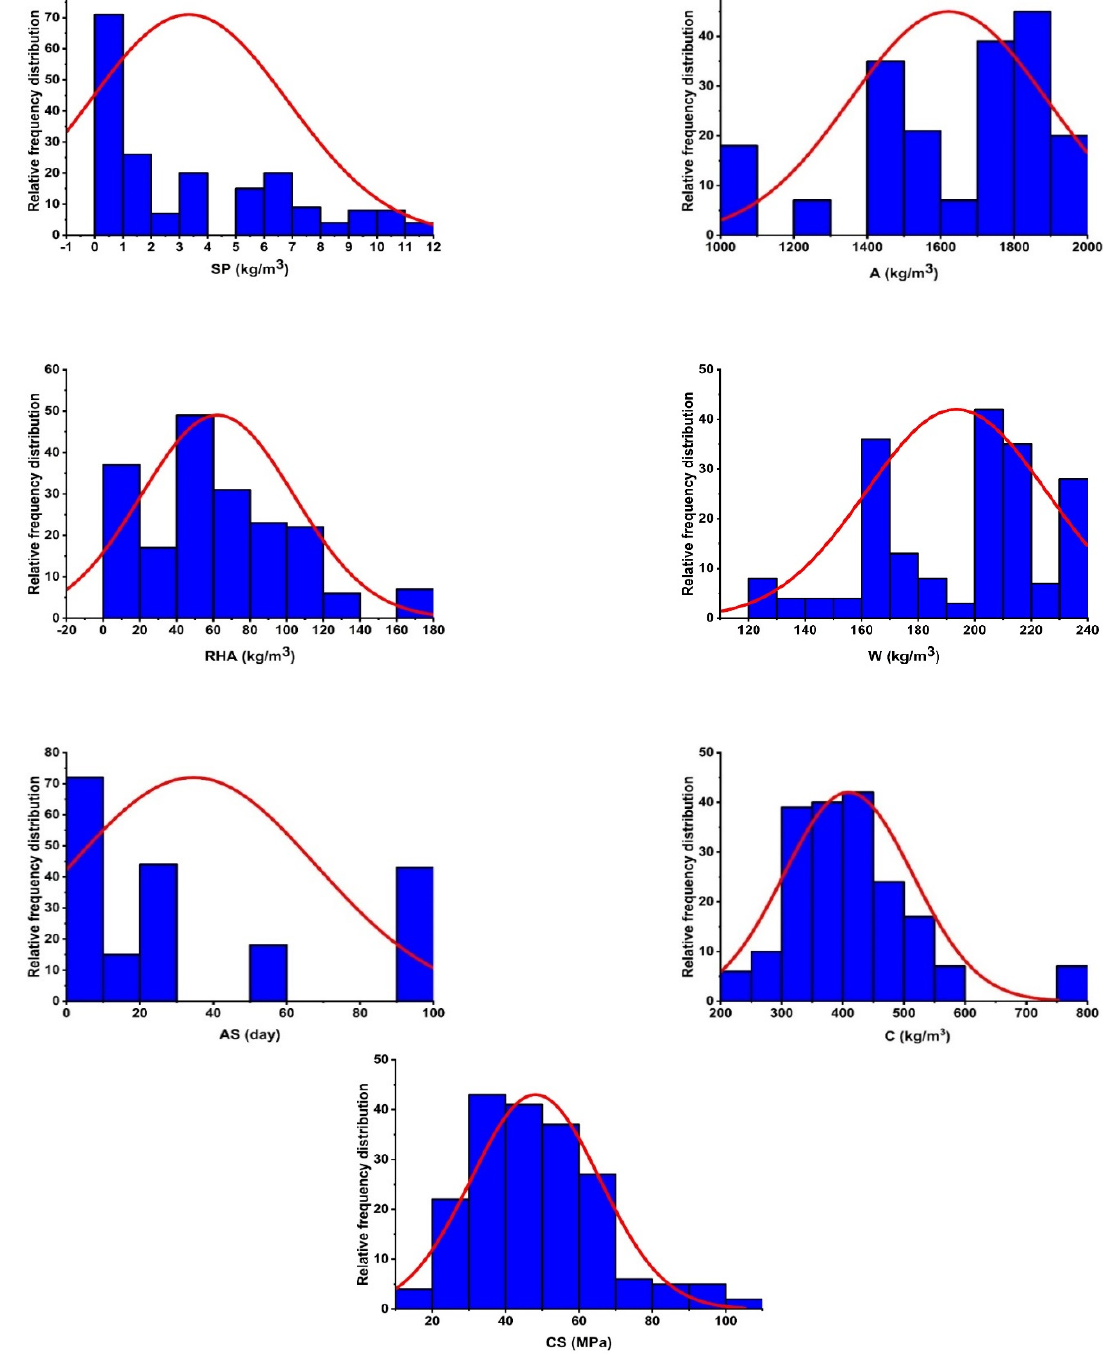
Figure 5. Histogram of variables used in making model. Table 2. Statistical description of variables.